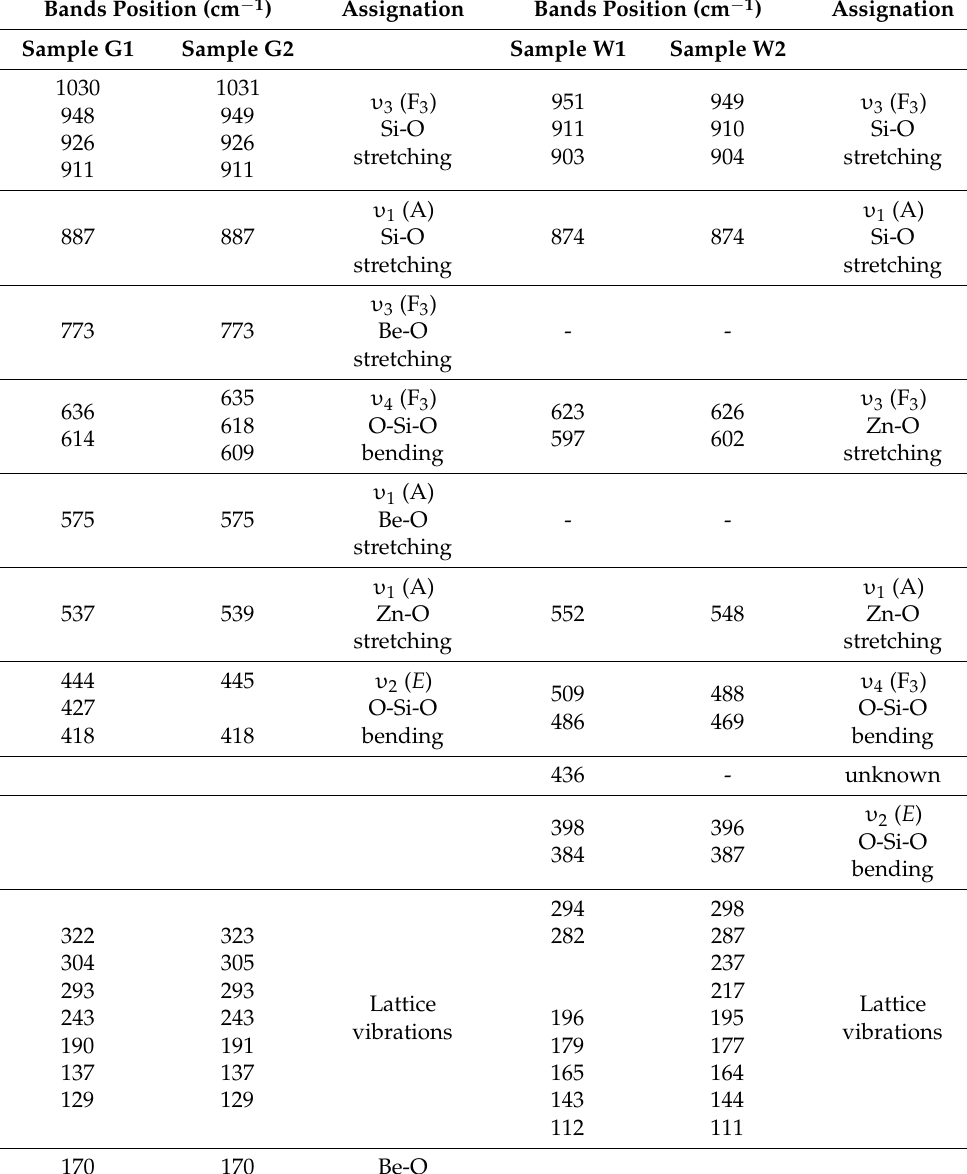
Table 6. Raman bands (position and assignment) of studied genthelvite and willemite